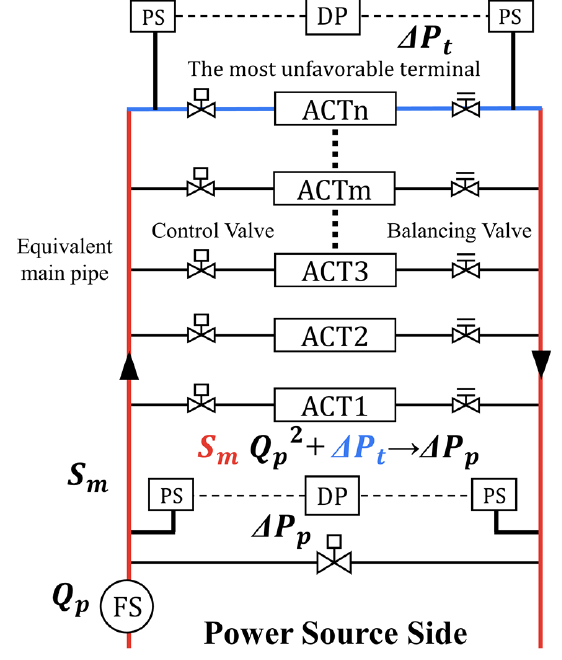
Figure 2. A typical air conditioning water system. ACT represents the air conditioner terminal; DP represents differential pressure; PS represents pressure sensor; FS represents the flow sensor; Q p represents the flow rate of the supply and return main pipeline; S m represents the impedance of equivalent main pipe; ∆ P p represents the differential pressure of the water supply and return main pipe; and ∆ P t represents the differential pressure of the most unfavorable terminal branch pipe.